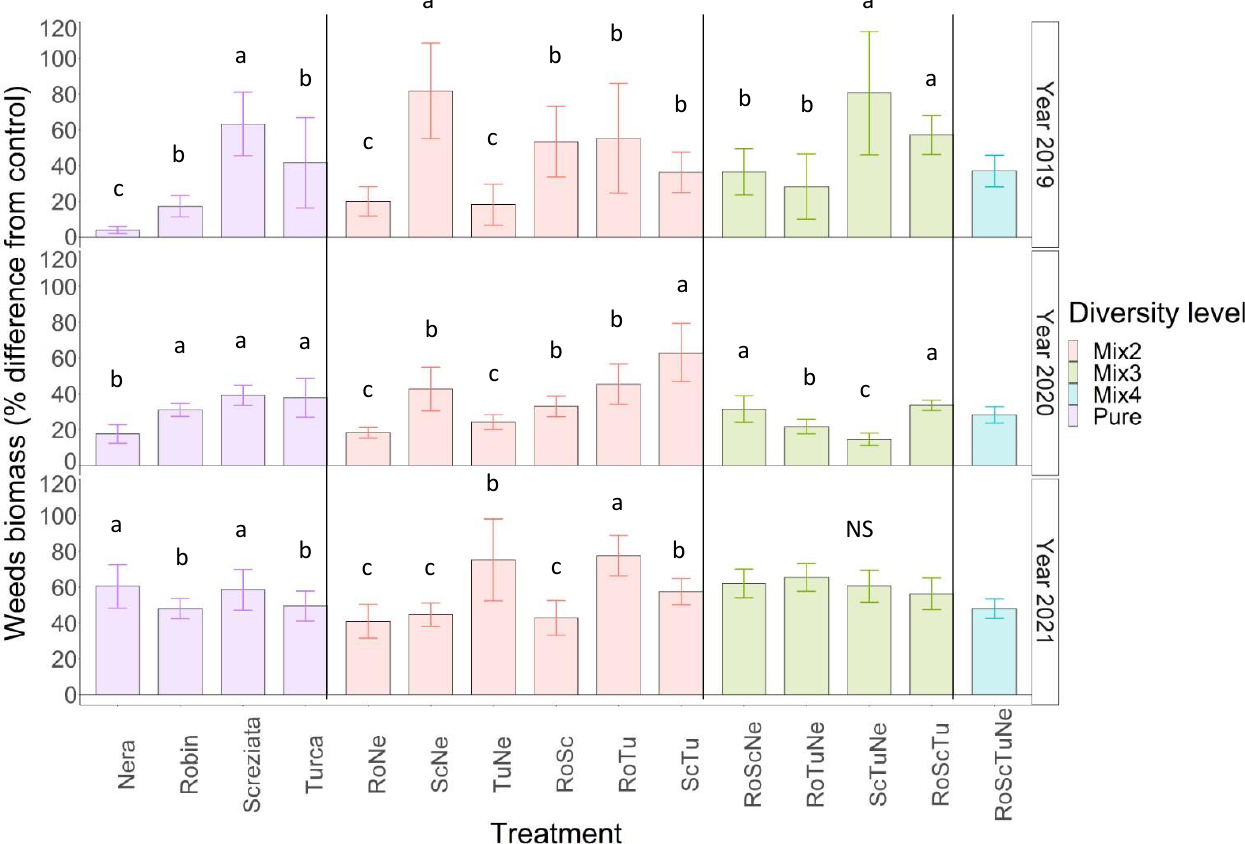
Figure 4. Weed biomass per cent differences from control in pure stands, mixtures of two cultivars, mixtures of three cultivars and mixture of four cultivars. Values are per cent differences from the control, calculated from the above-ground biomass dry weight: a value of 60% means that the weed biomass represents 60% of the yearly control. Different letters indicate statistical significance at the p ≤ 0.05 level (Bonferroni -based method) among treatments. NS means no statistical significance with p ≤ 0.05. Ne = Nera, Ro = Robin, Sc = Screziata, Tu = Turca.